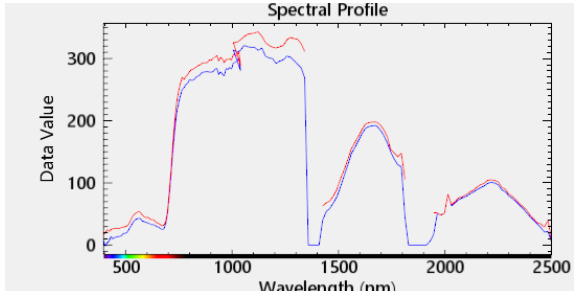
Figure 6 . Comparison of ZY1-02D vegetation spectral curve